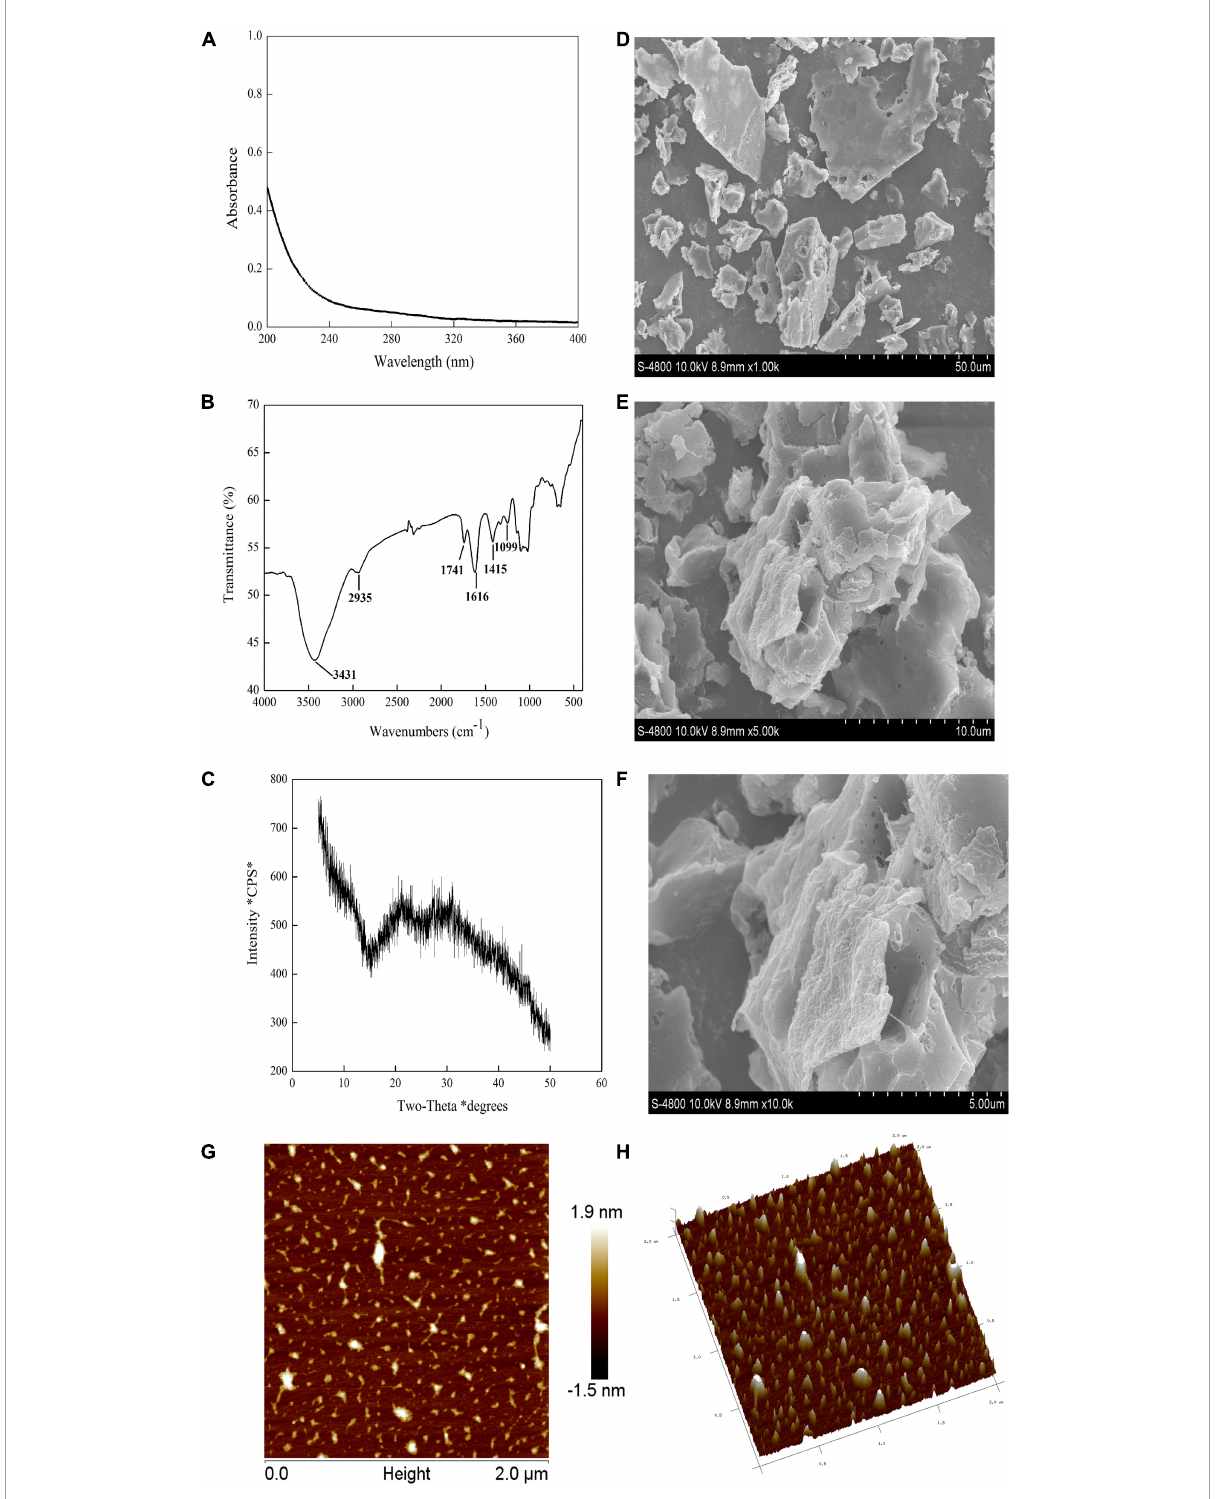
FIGURE2 PZMP3-1’s physicochemical analysis. (A) The X-ray diffraction (XRD) pattern. (B) The spectrum of UV-vis. (C) The spectrum of Fourier transforms infrared spectroscopy (FT-IR). (D,E) Scanning electron microscopy (SEM) images [ × 1,000 in panel (D) , × 5,000 in panel (E) , and × 10,000 in panel (F) ]. (G) Atomic force microscopy (AFM) images; (H) a three-dimensional image of